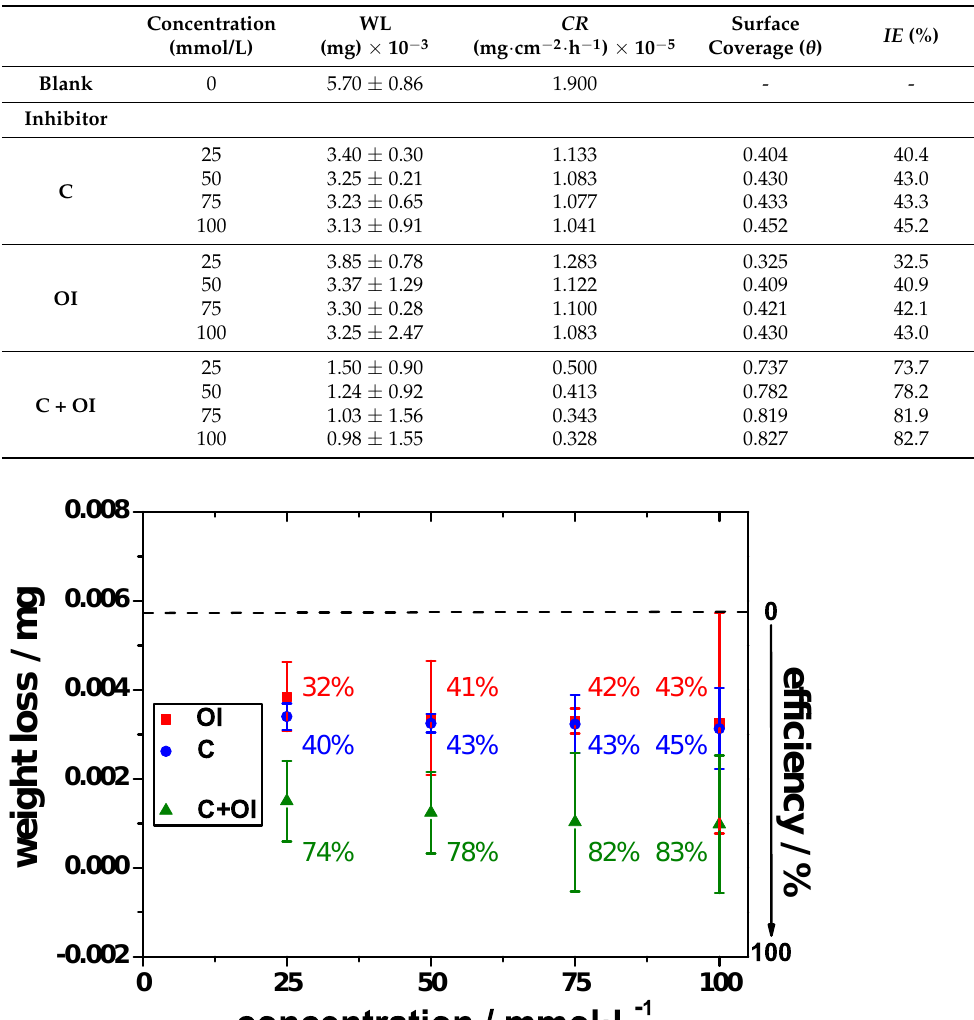
Table 2. WL results for CR , θ and IE for steel CR4 samples dip coated in different concentrations of C, OI and C + OI after immersion in 0.1 M NaCl at RT for 24 h.